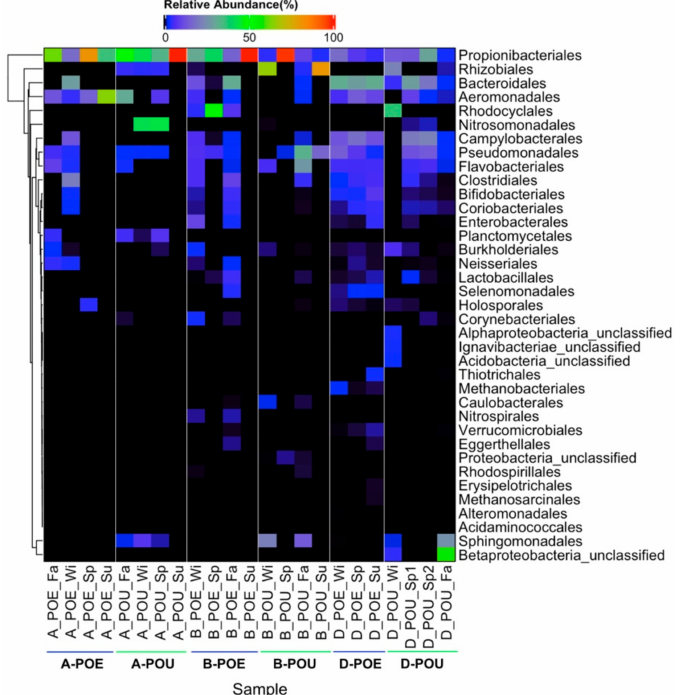
Figure 1. Heatmap for bacterial composition of water samples. Relative abundance of 37 bacterial orders (rows, including five unclassified orders) across 23 water samples (columns) is obtained based on assembled contigs of metagenomes. Names of water samples were based on Supplementary Table S1, and indicate the sampling sites, sample type and sampling season of each water sample. Cell color indicated the percentage of relative abundance for each bacterial order, and black cells indicated non-detection of bacterial order in the sample. Heatmap was separated through sampling sites (A, B, D) and sample type (POE vs.